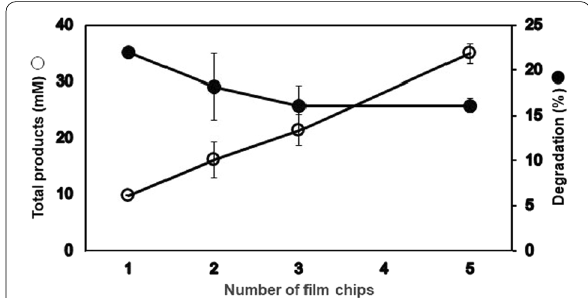
Fig. 2 Effect of numbers of 6 mm PET films. Reactions were ∅ performed at 70 °C for 3 days, using Cut190*SS, 100 mM HEPES (pH 8.5) and 6 mm PET-GF film (approximately 9.5 mg/each ∅ corresponding to 49.4 μmoles as monomer unit/each) in a 1-ml reaction mixture, as described in “Materials and methods”